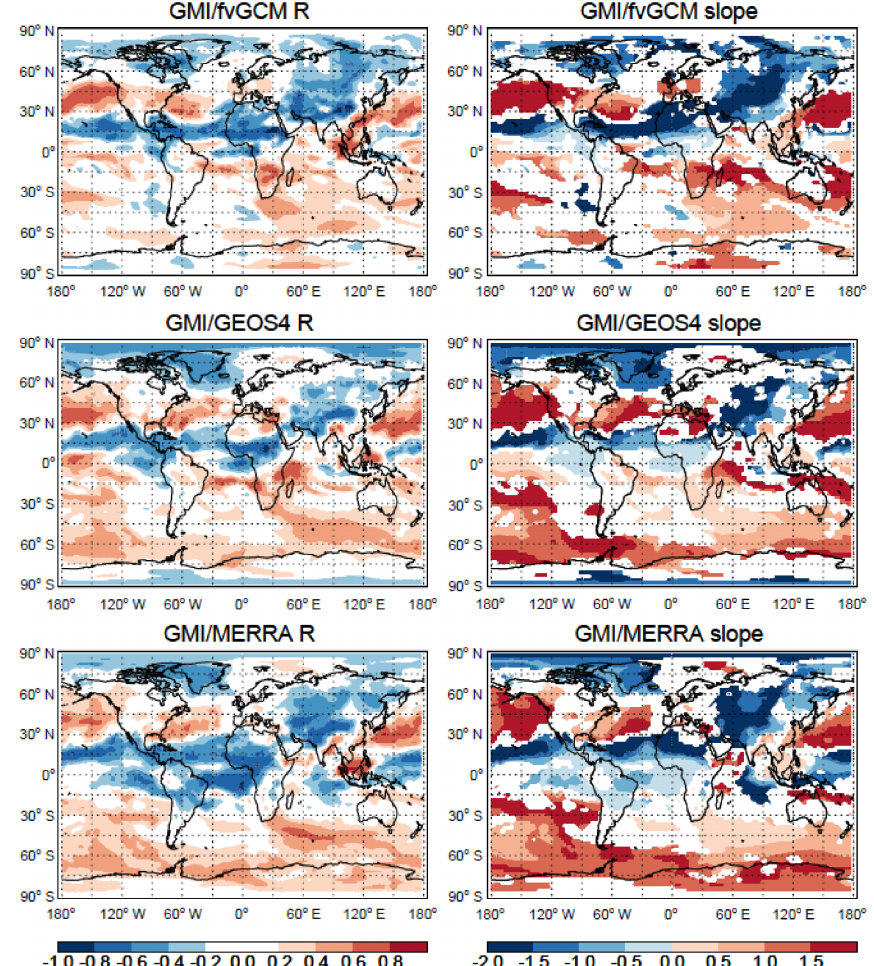
Figure 12. O 3 –CO correlation coefficients ( R ) and linear regression slopes (dO 3 / dCO) at 618hPa in the GMI model driven by the fvGCM (1995), GEOS-4 (2005), and MERRA (2005) meteorological fields. Results are calculated in 2 ◦ × 2.5 ◦ grid cells using 3-hourly model output and the reduced major-axis method. White areas denote absolute values of O 3 –CO correlation coefficients less than